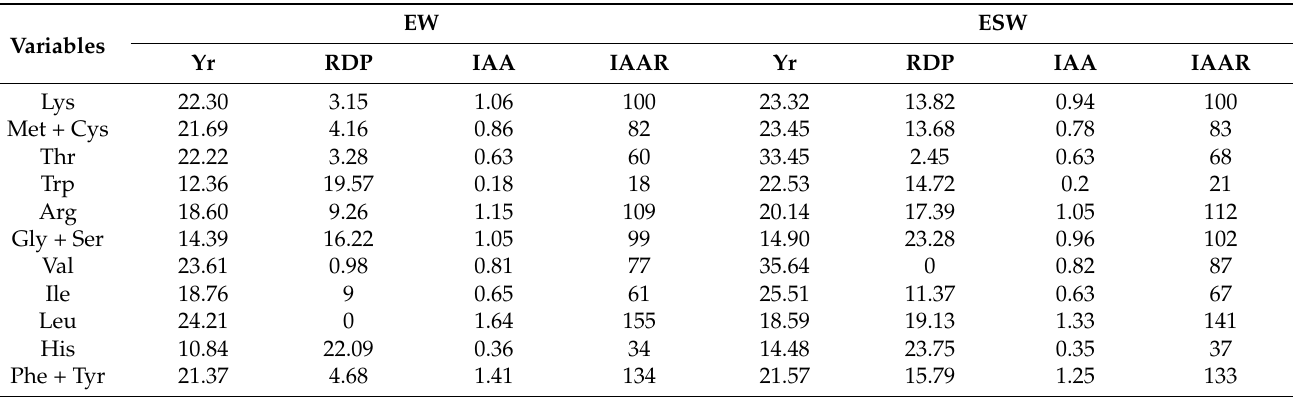
Table 6. Summarized results of the individual amino acid deletions for egg weight (EW) and eggshell weight (ESW) of Japanese quail’s